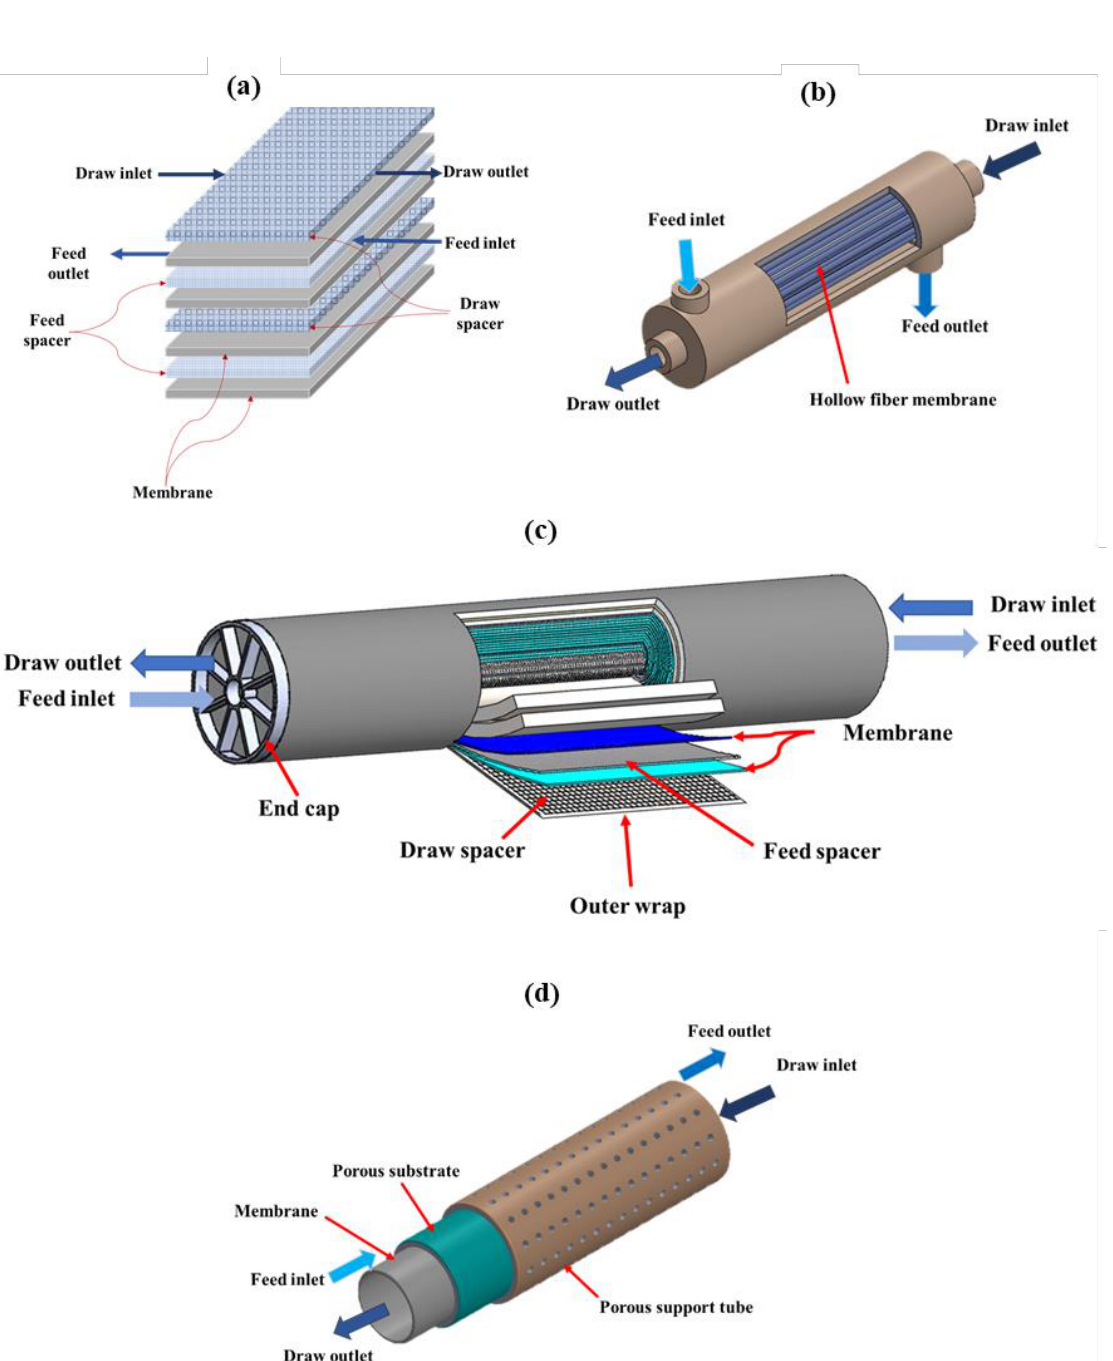
Figure 5. A 3D schematic of the ( a ) plate-and-frame module, ( b ) hollow fiber module, ( c ) spiral wound module, and ( d ) tubular module.